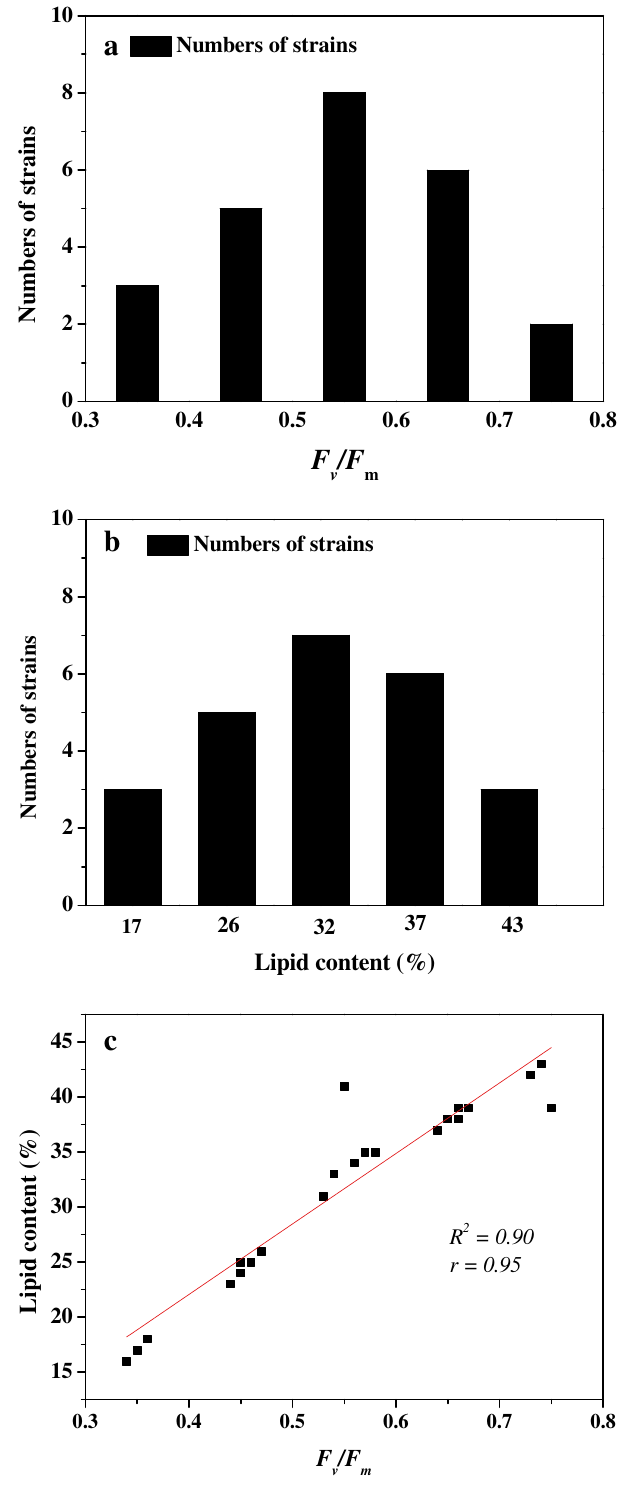
Figure 1. Distribution histogram of the SO120G mutant phenotypes. ( a ) Distribution histogram of the photosynthesis efficiency mutants (PEMs); ( b ) distribution histogram of the lipid-over-production mutants (LOMs); and ( c ) the relationship between the lipid contents and F v / F m under stress conditions in the PEMs and LOMs of